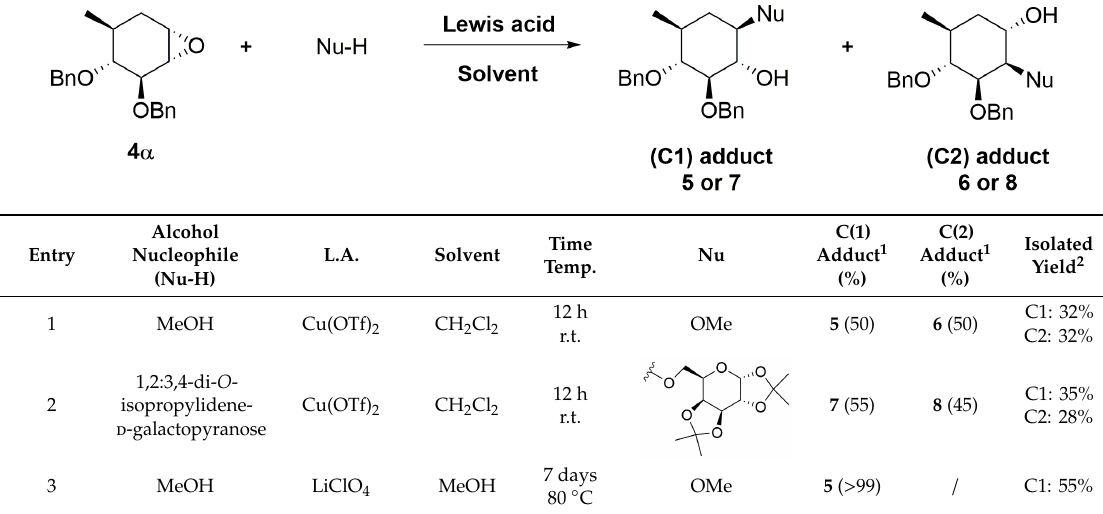
Table 1. Lewis acid (L.A.)-mediated ring-opening addition of alcohol nucleophile (Nu-H) to epoxide 4 α .